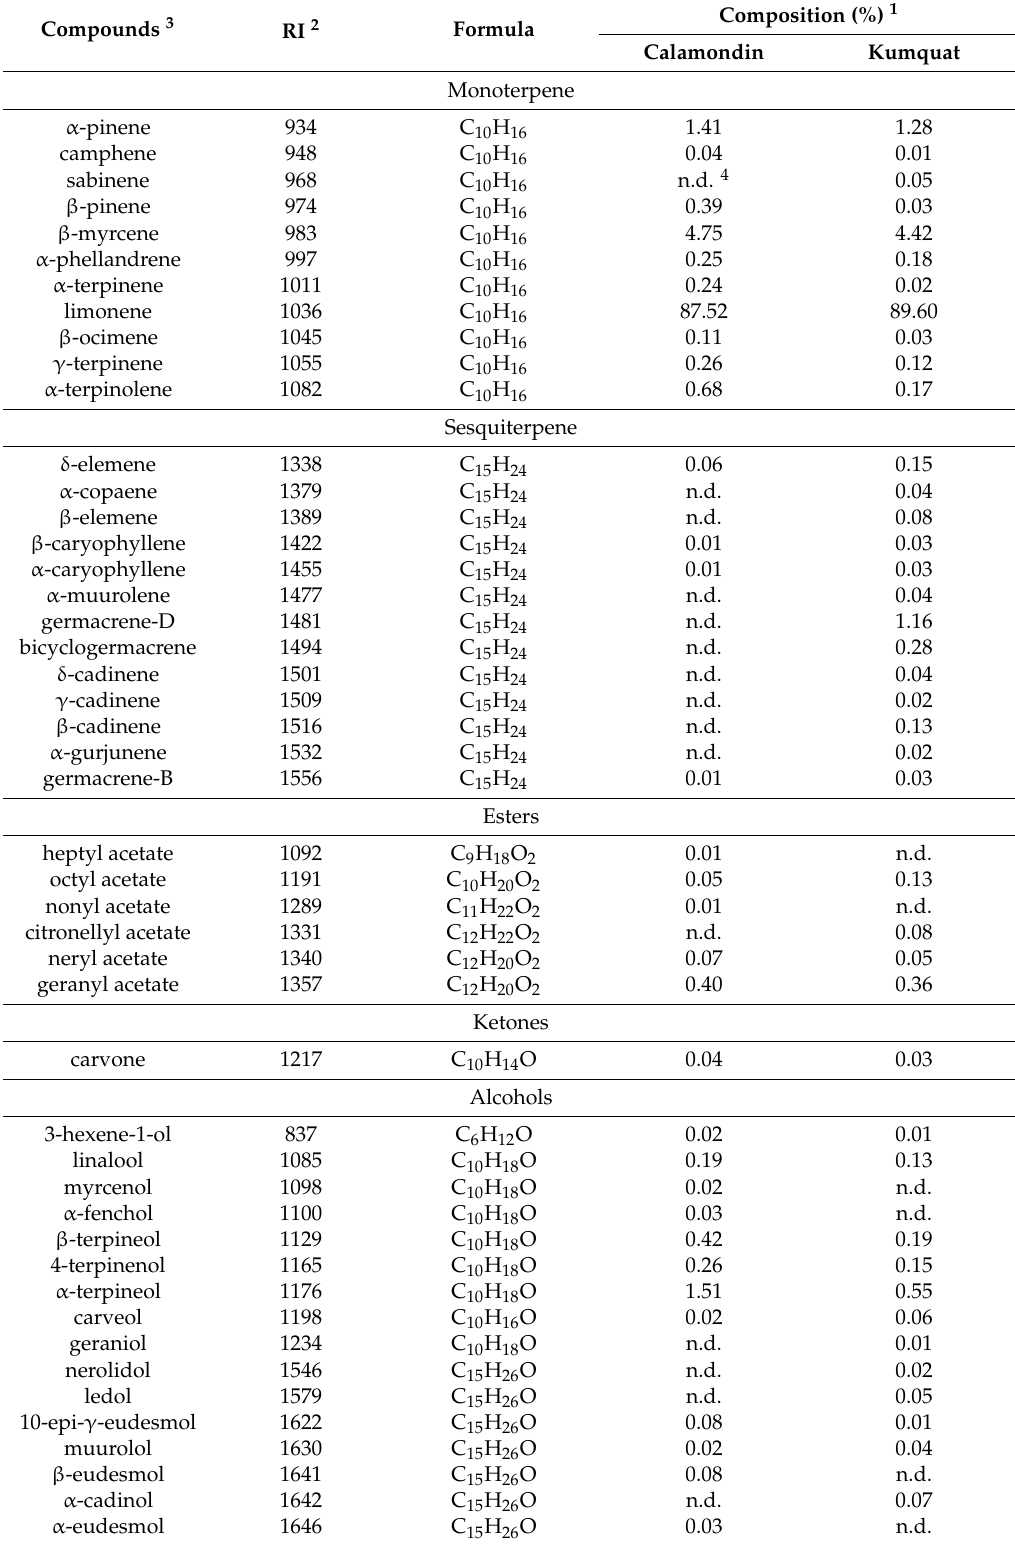
Table 1. Volatile constituents (%) of small-size